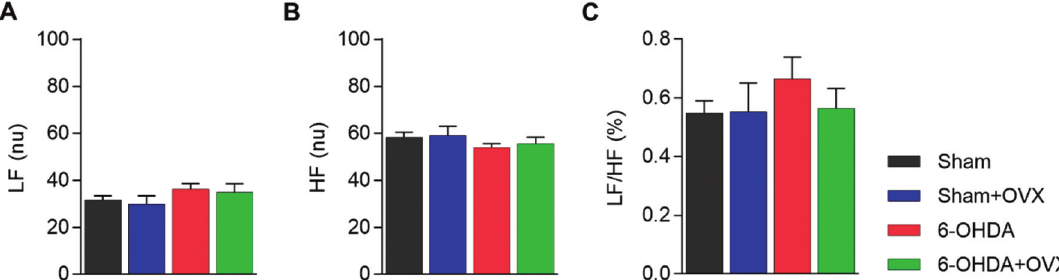
Figure 3 - Frequency domain analysis of heart rate variability (A) LF. (B) HF. (C) LF/HF. Data are expressed as mean ± standard error of the mean. Data are analyzed using GLM multivariate with the Sidak post-hoc test. (LF, the low-frequency component in normalized units; HF, the high-frequency component in normalized units; LF/HF, the ratio between LF and HF; 6-OHDA, 6-hydroxydopamine; OVX, ovariectomized).